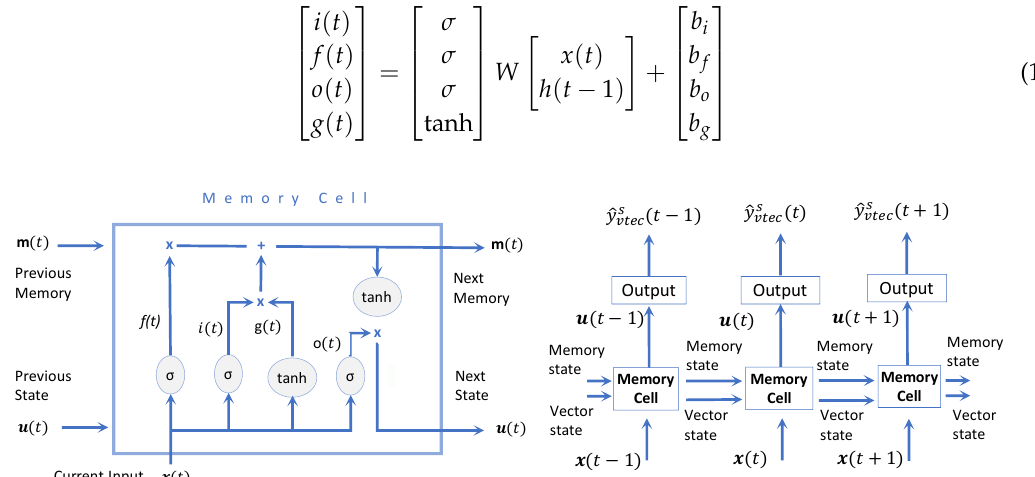
Figure 2. The memory cell of an LSTM network. It contains three different components; (i) the forget gate f(t), (ii) the input gate i(t) and the input node g(t) and (iii) the output node o(t) ( right ). Unidirectional LSTM regression model used for TEC estimation ( left